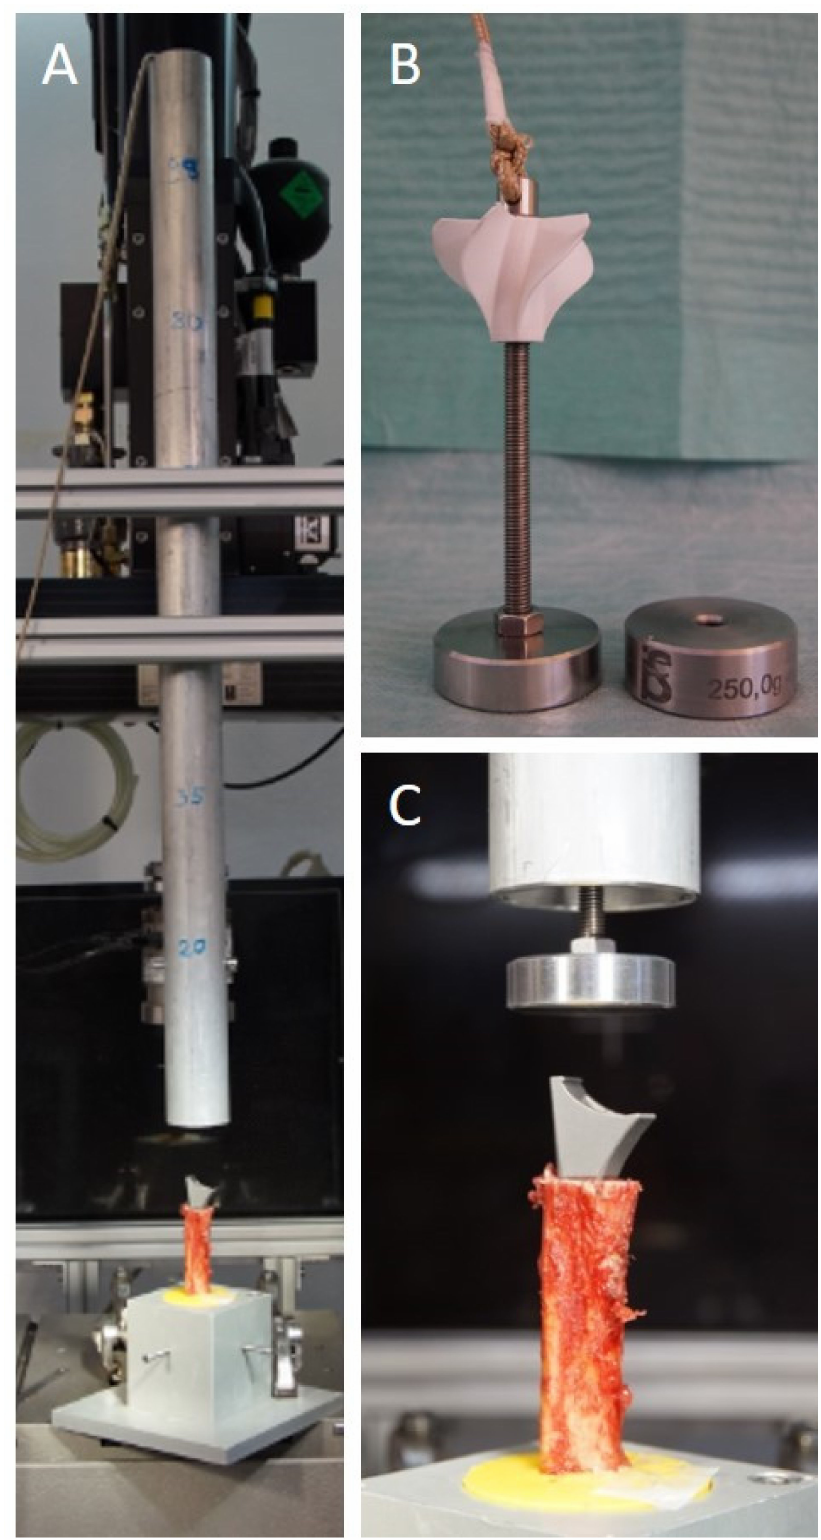
Figure 4. ( A ) Complete biomechanical test-setup with the downpipe placed vertically above the specimen. ( B ) 250 g (+additional 250 g) weight placed inside the tube can be released from different heights by releasing a metal pin. ( C ) The released weight falls down the tube and simulates the mallet strike on the